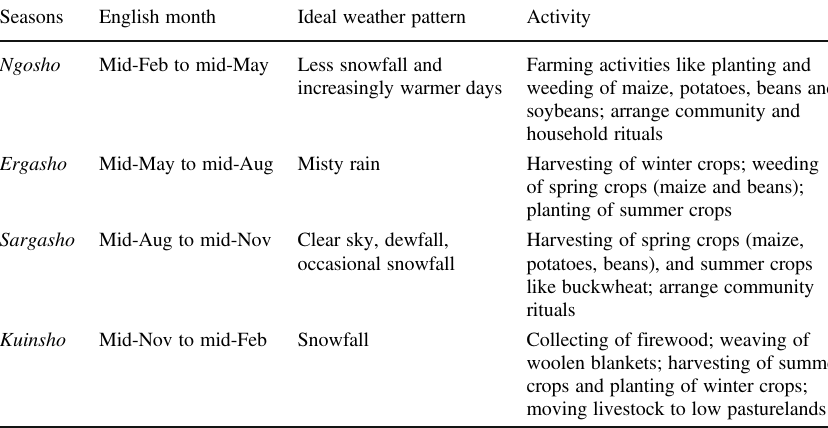
Table 1 The nomenclature of seasons and the relevant social activities of